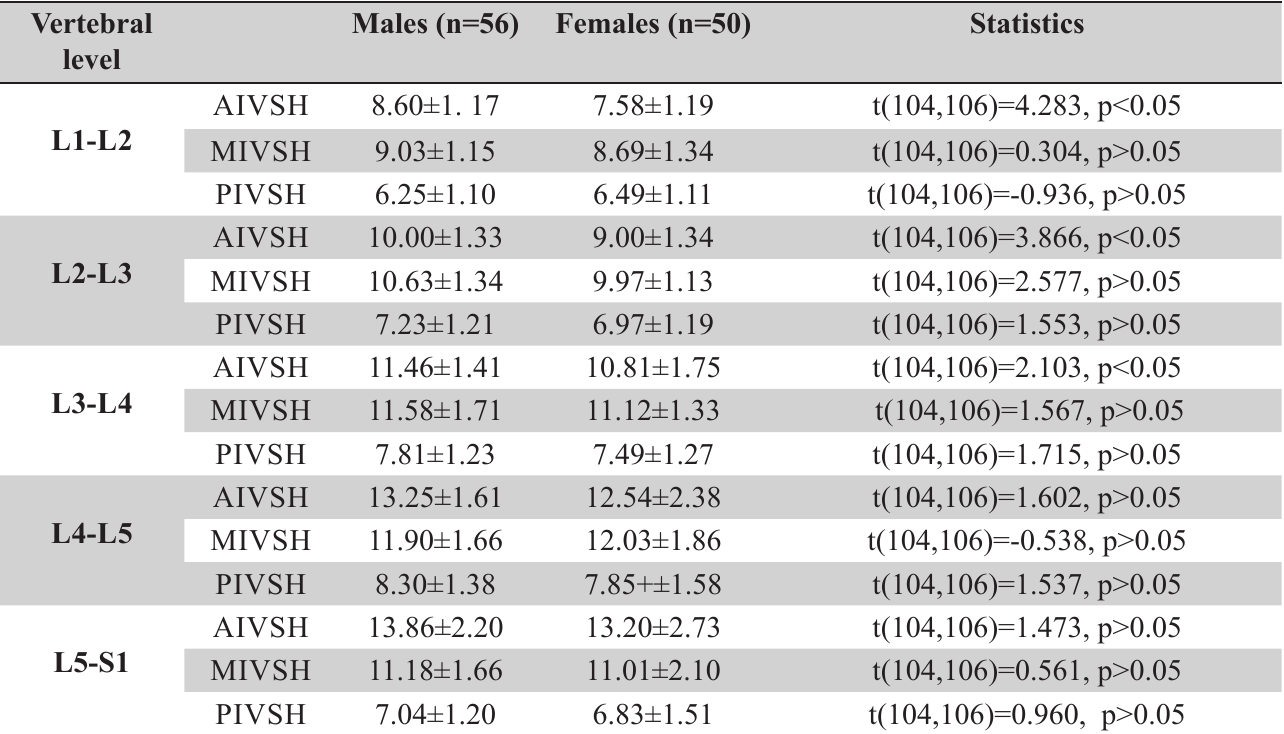
Table 2. Gender-wise comparison of intervertebral space heights (mm) at various vertebral level. Vertebral